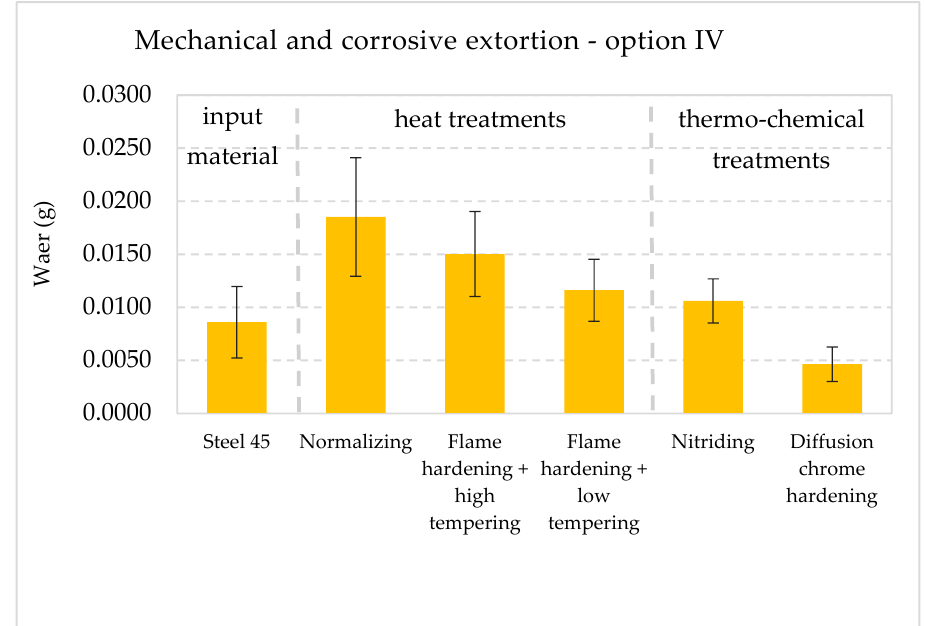
Figure 16. Wear I M + I C in the conditions in mechanical and corrosive conditions (no action from abrasive agents) with 90% confidence semi-intervals [40].